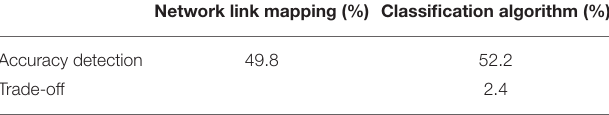
TABLE 1 | Detection accuracy comparison between the proposed algorithm and classification algorithm.